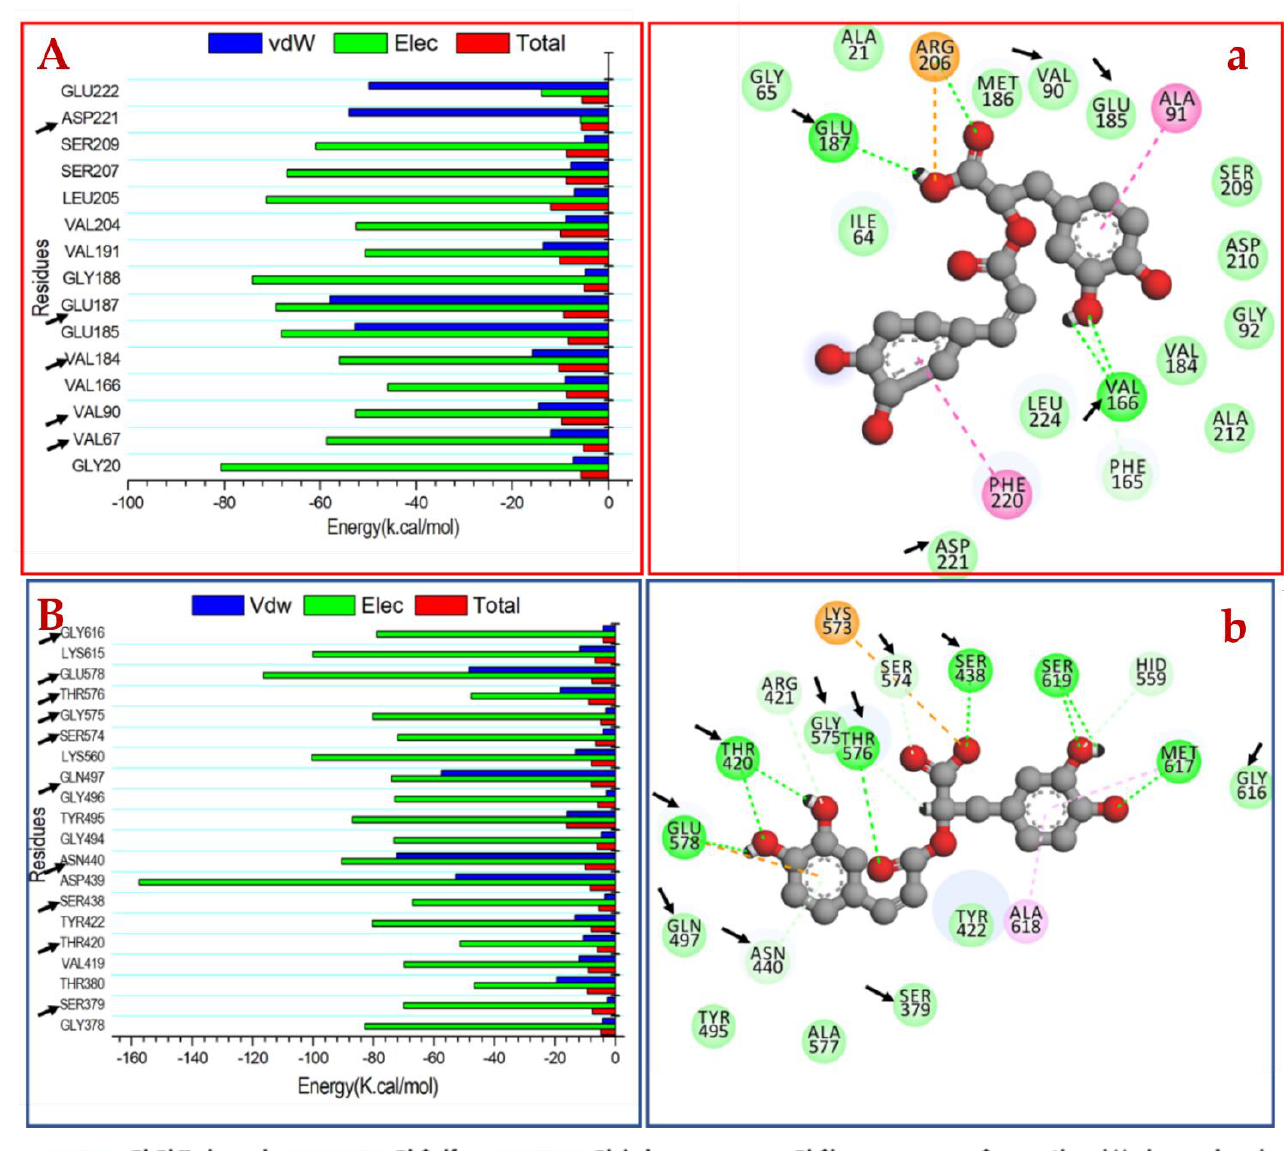
Figure 7. Per-residue decomposition plots showing the energy contributions to the binding and stabilization of RA at the Catalytic active site of ( A ) peptidoglycan transpeptidases and ( B ) H. pylori urease receptor. Corresponding inter-molecular interactions are shown in ( a ) peptidoglycan transpeptidases and ( b ) H. pylori urease.